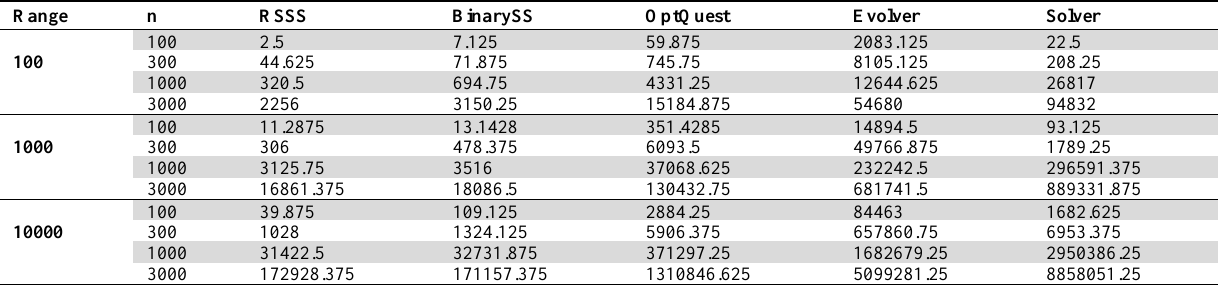
The average GAP of several methods